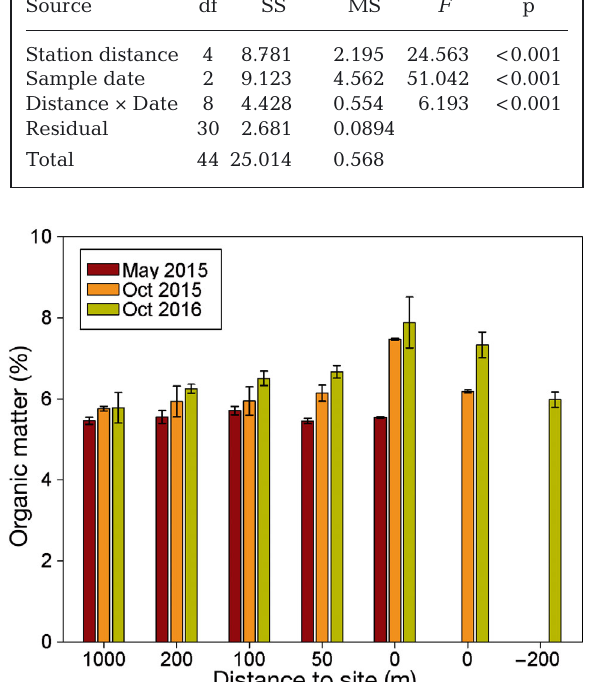
Fig. 9. As in Fig. 8, but for Navy